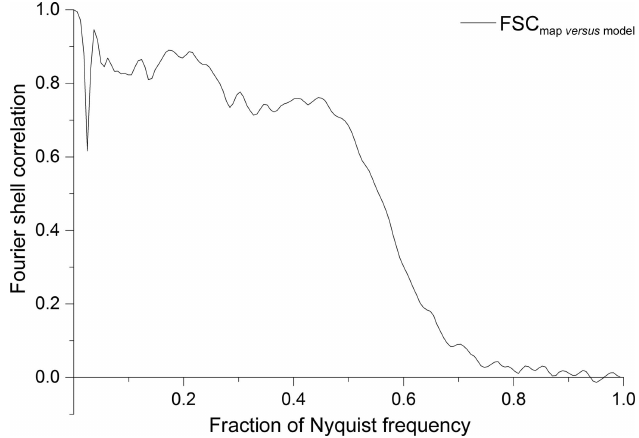
Figure 13 Fourier shell correlation plot of the model (protomer) versus the map (masked 1/12th subunit; van Heel et al. , 2000). The atomic model was deposited as PDB entry